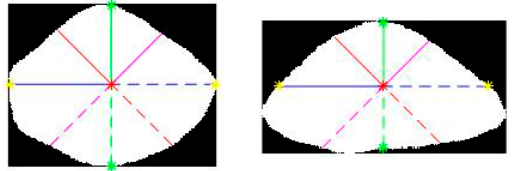
Figure 7. Required dimensions to determine the shape of the object.